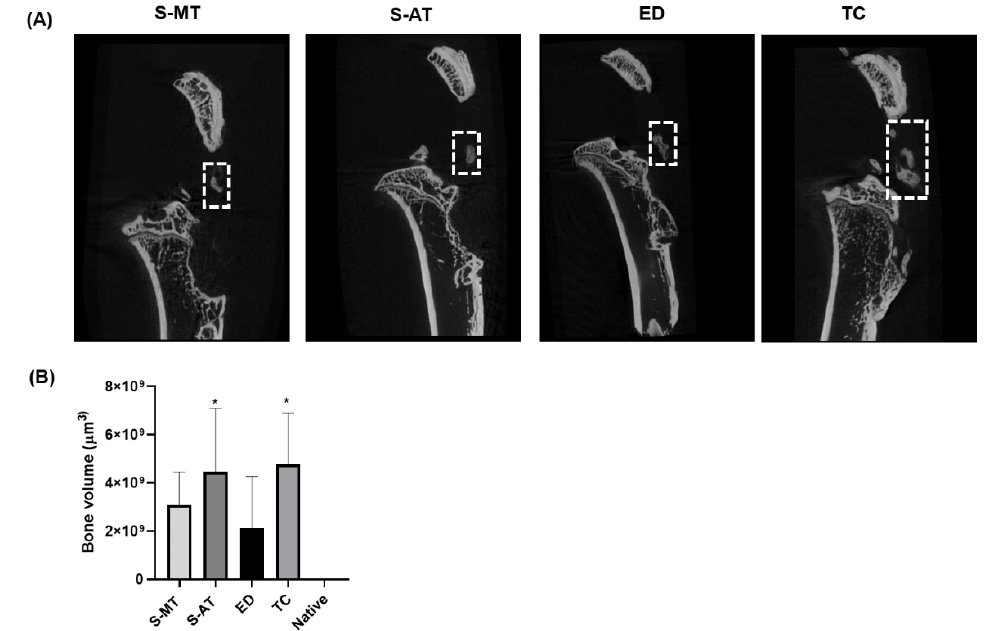
Figure 3. ( A ) µ CT scans of the specimens harvested at 12 weeks after surgery. Detected ossification in the tendon tissue is indicated with dashed squares. ( B ) Comparison of bone volume (ossification) found in the tendon tissue for each of the treatment groups (S-AT with abrupt transition and S-MT with mixed transition) and the control groups (TC, transversal cut; ED, empty defect). Bone volume calculations are expressed relative to native tissue, with statistically significant differences denoted * p ≤ 0.05 from 6 samples.